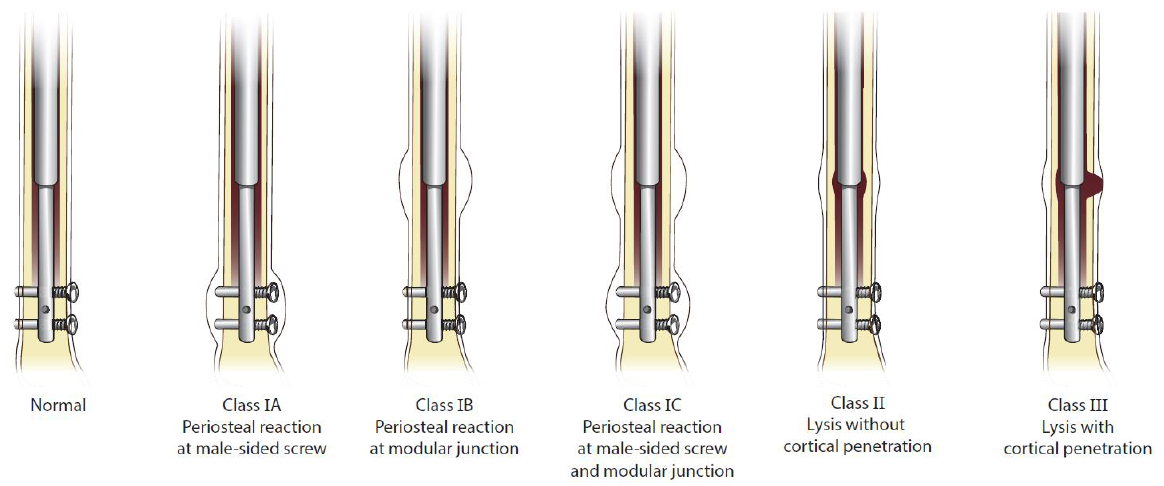
Figure 1. Biologic Reaction Classification System.